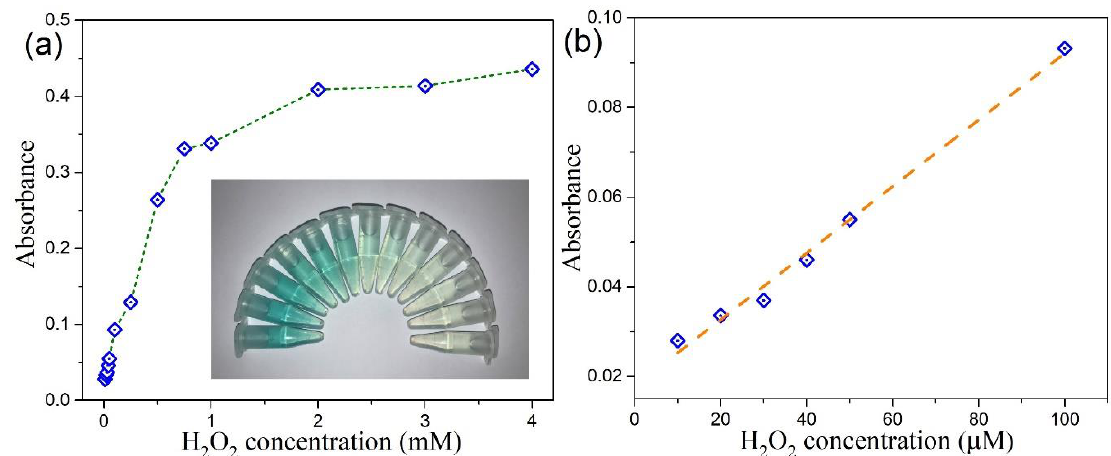
Figure 13. ( a ) The absorbance changes at 652 nm for MoSe 2 QDs in different amount of H 2 O 2 (0.01, 0.02, 0.03, 0.04, 0.05, 0.1, 0.25, 0.5, 0.75, 1, 2, 3 and 4 mM). Inset: the images of color contrast for different concentrations of H 2 O 2 . ( b ) The linear calibration plot for H 2 O 2 .